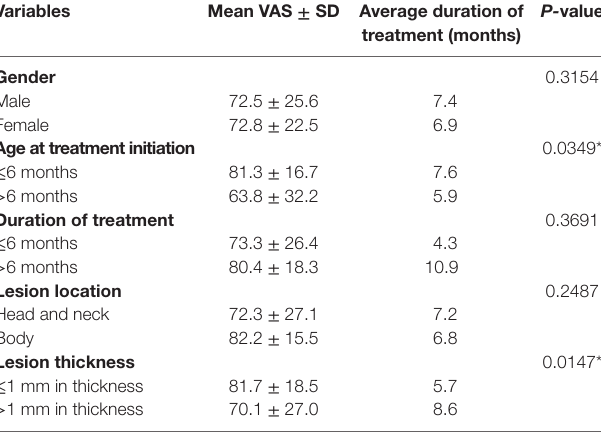
TaBle 2 | Analysis of predictors of clinical response.